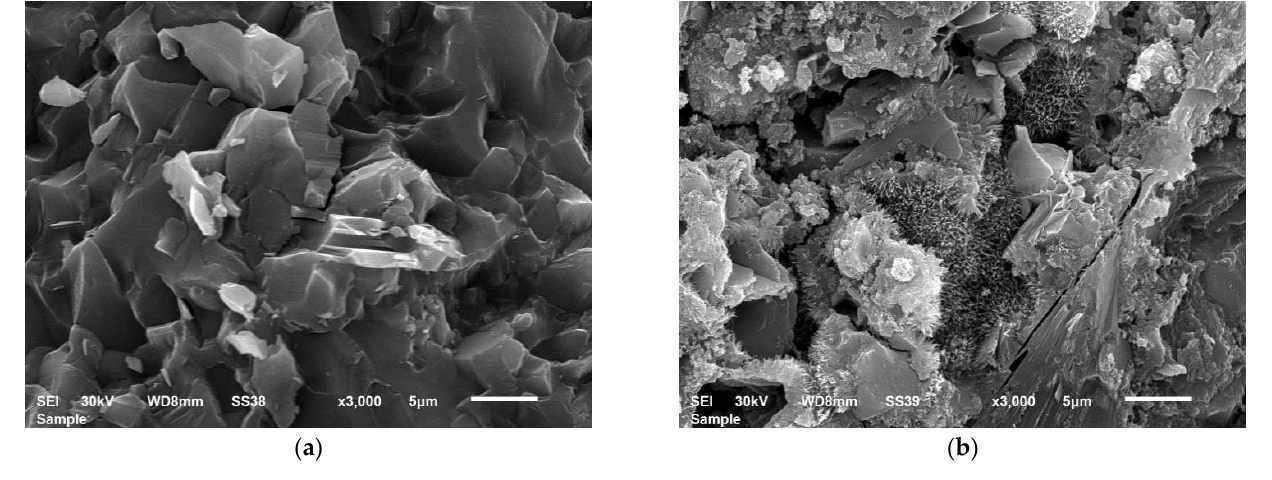
Figure 10. SEM images of the fracture surface of volcanic concrete made with TW: ( a ) 0%VA and ( b ) 5% VA.